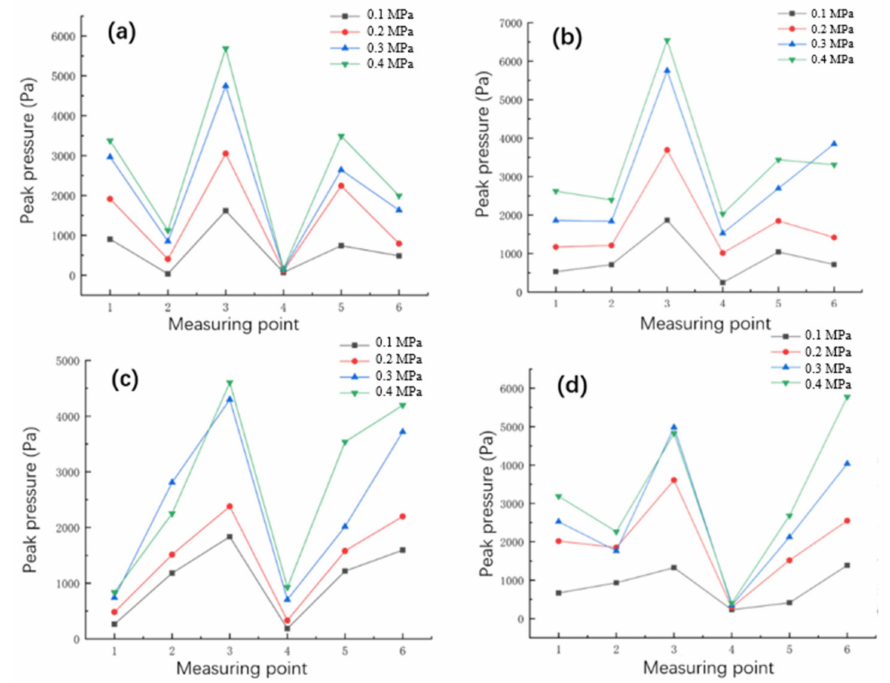
Figure 5. Influence of blowing pressure and length of slotted blow hole under a blowing distance of 20 mm on peak pressure: ( a ) two slotted blow holes, ( b ) three slotted blow holes, ( c ) four slotted blow holes, and ( d ) five slotted blow